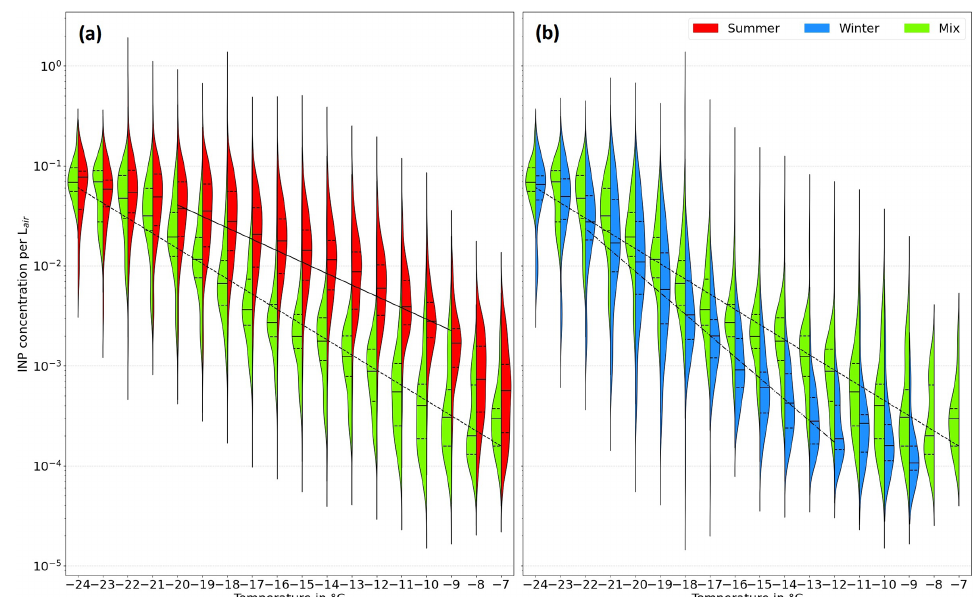
Figure 6. Violin plots of the N INP ( T ) frequency distribution from − 7 to − 24 ◦ C, given in the typical color used for the corresponding types ( a : summer type; b : winter type; both panels: mix type, shown in both panels for reference). For the distributions, solid horizontal lines show the median, and dashed horizontal lines show the 25th and 75th percentile, respectively. The parameterizations suggested in this study are also plotted as a solid black line (summer) in panel (a) , a dash–dot black line (winter) in panel (b) and a dashed black line (mix) in both